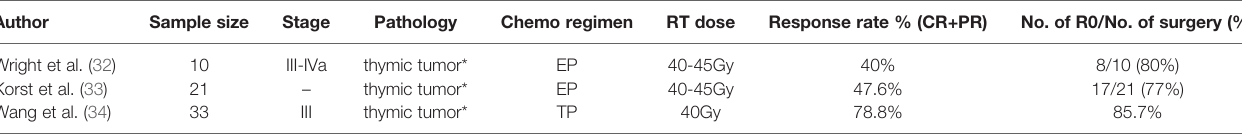
TABLE 3 | Induction chemoradiotherapy for locally advanced thymoma.